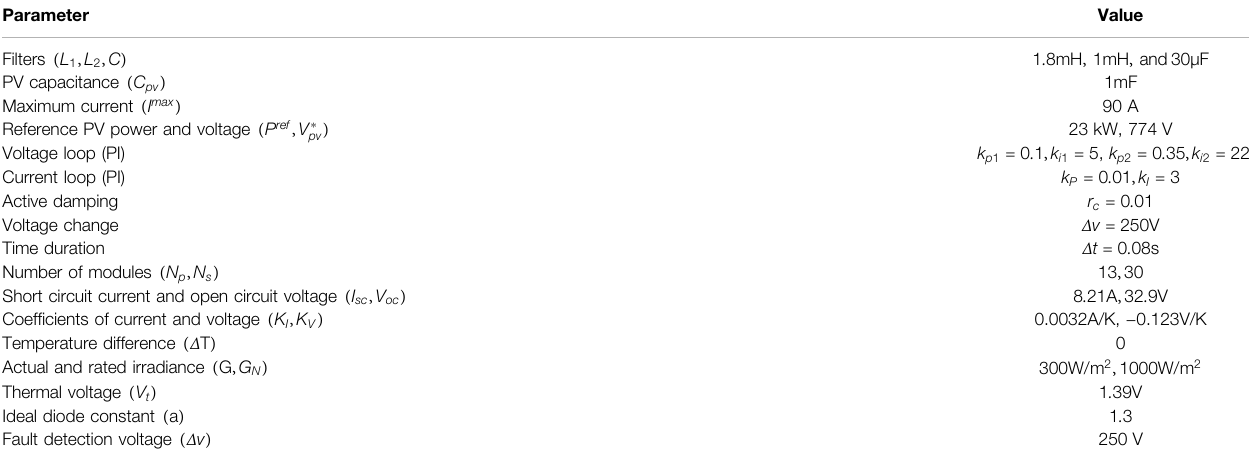
TABLE 1 | Parameters of the system and the PV